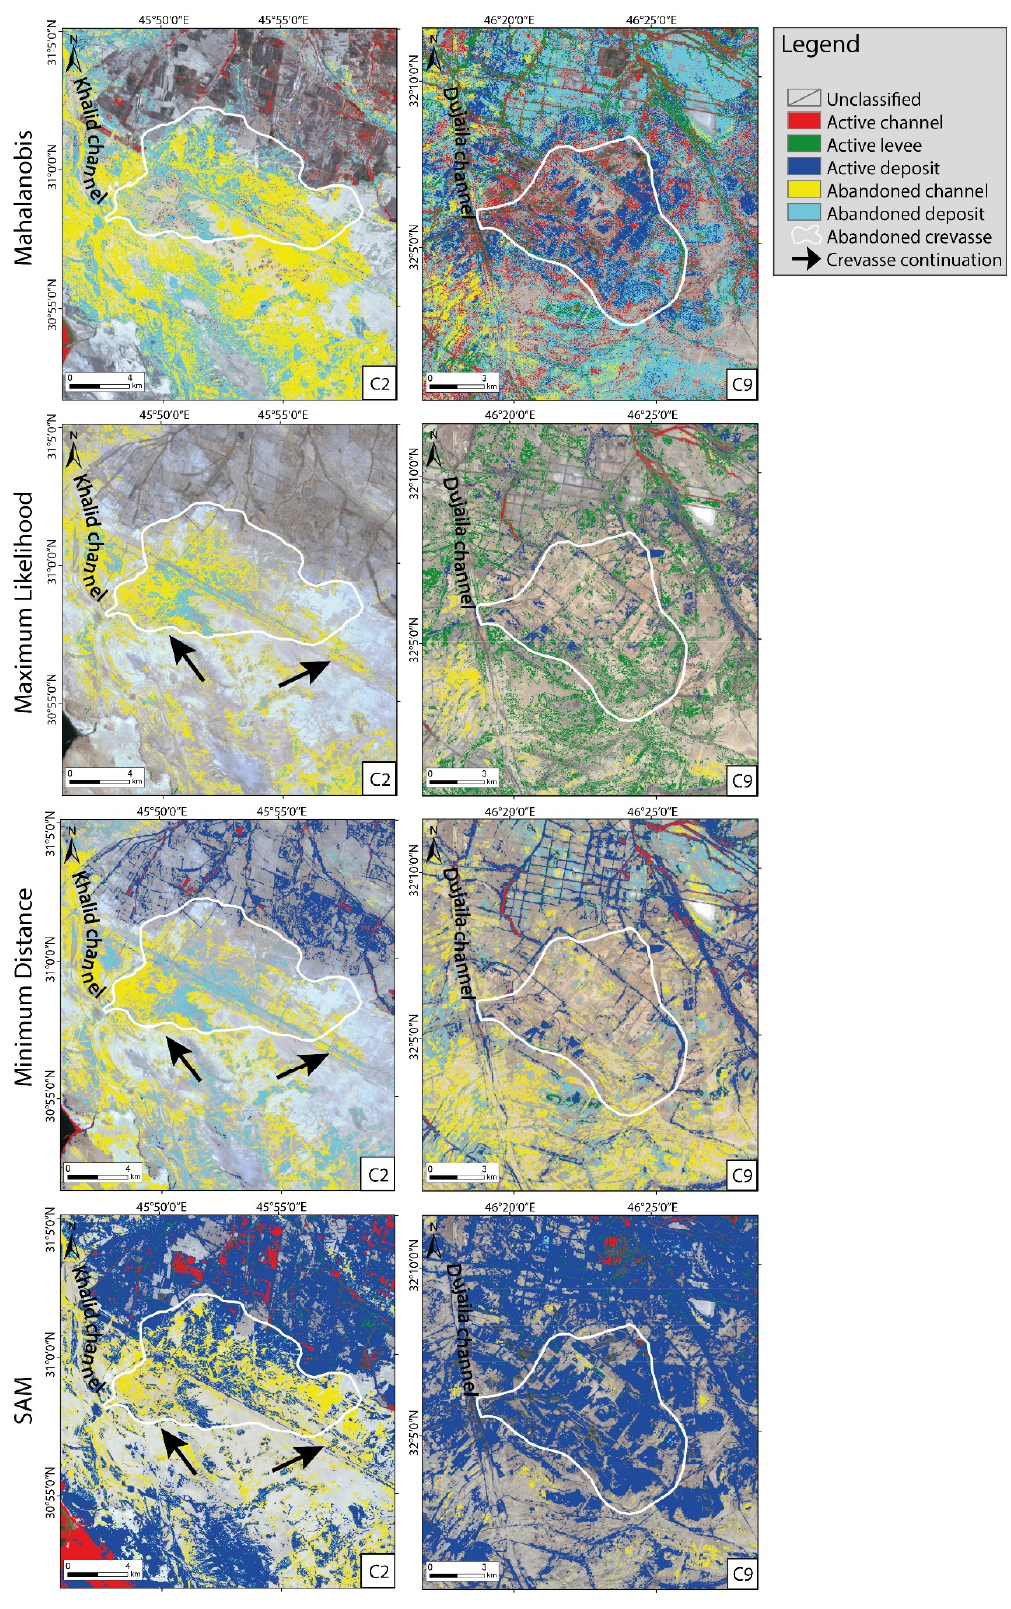
Figure 13. Classified abandoned crevasse splay ( C2 , C9 ) using four classification methods. For the Mahalanobis and Minimum Distance the wettest period is shown, while for the Maximum Likelihood and SAM is the driest period.